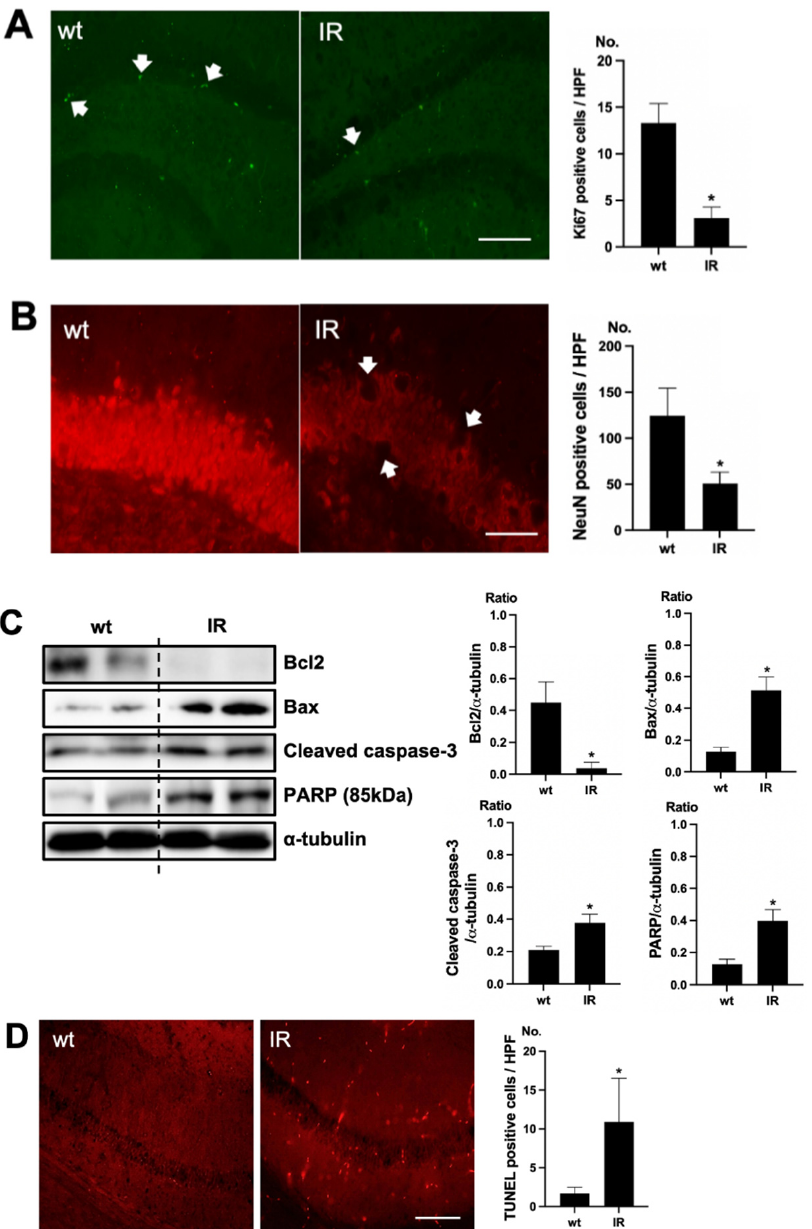
Figure 2. Brain damage in ischemia-reperfusion (IR) kidney. ( A ) Representative immunofluorescence stain of subgranular zone of the hippocampal DG of brain section: Immunofluorescent staining was performed using the markers of proliferation (Ki67) in brain. High power field (HPF), original magnification, 200 × . Scale bar = 50 µ m. ( B ) Representative immunofluorescence stain of subgranular zone of the hippocampal DG of brain section: Immunofluorescent staining was performed using the neuronal nuclei marker (NeuN) in the brain. Original magnification, 400 × . Scale bar = 200 µ m. ( C ) Representative Western blot of brain lysis: Western blot analysis shows renal injury—increased Bax, cleaved caspase3 expression, and decreased Bcl2 expression in the brain of uremic mice. Renal injury increased PARP (85 kDa) expression in the brain of uremic mice. ( D ) Representative TUNEL stain of subgranular zone of the hippocampal DG of brain section. Original magnification, 200 × . Scale bar = 50 µ m. * p < 0.001 vs. wt. Bar represents mean ± S.D. (wt, wild-type sham; IR, IR renal injury in wild-type